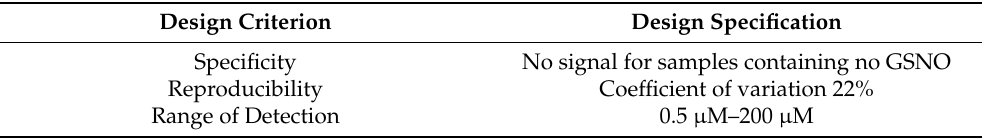
Figure 2. Chemiluminescence signal using the photolysis device in vitro. ( A ) GSNO standard curve. Plotting the averaged NO values against the initial GSNO concentrations in vitro yielded a strong linear relationship. The associated equation was used to correlate NO release with known concentrations and eventually to estimate the concentration in biological samples. “y” is NO released, and “x” is the initial SNO concentration: y = 1.264x + 20.635. ( B ) Comparison of chemiluminescent signal of L-CSNO and NaNO 2 . We measured NO release from NaNO 2 and L-CSNO dissolved in PBS. NO evolved from increasing concentrations of NaNO 2 was between 0.3 and 0.4 ppb, which is equal to ambient air (N = 3), while L-CSNO gave proportional increase in NO signaling (from 1.5 to 7.9 ppb) with its increased concentration (ANOVA, N = 3, each, p ≤ 0.0001). Table 2. Summary of achieved design specifications.